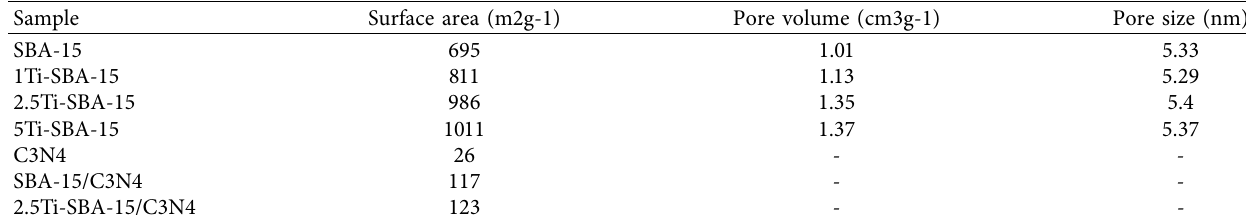
Figure 2: (a) XRD patterns; (b) and (c) Nitrogen sorption isotherms; (d) Pore size distributions of synthesized materials. Table 1: Pore structure character parameters of the synthesized